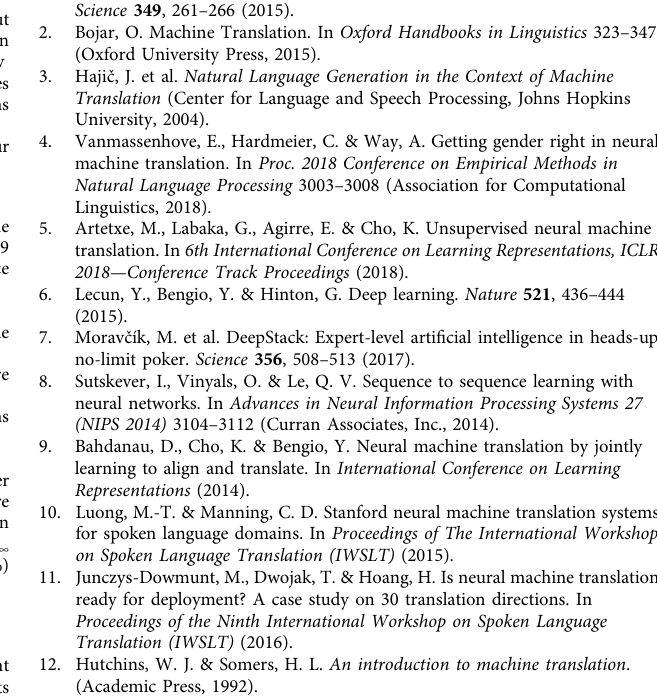
Fig. 2. The WMT13 newstest (3000 sentences) was used to evaluate two properties of the systems over time: translation diversity and generation of novel translations by checkpoint averaging. These properties were analyzed over the time of the training (up to 1 million steps), during which checkpoints were saved every hour (up to 214